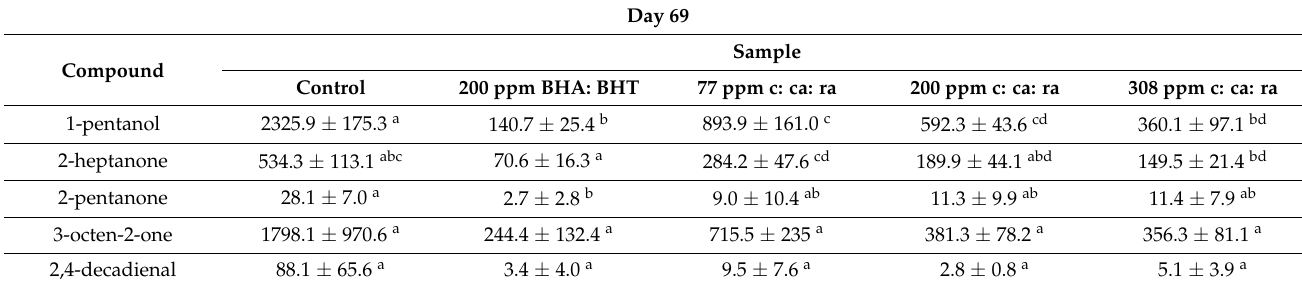
Table A9. Levels of volatile compounds ( µ g/kg of FFMP) as measured with HS-SPME-GC-MS analysis in FFMPs with or without antioxidants, after accelerated storage (40 ◦ C, RH 23%) for 69 days 1, 2, 3, 4